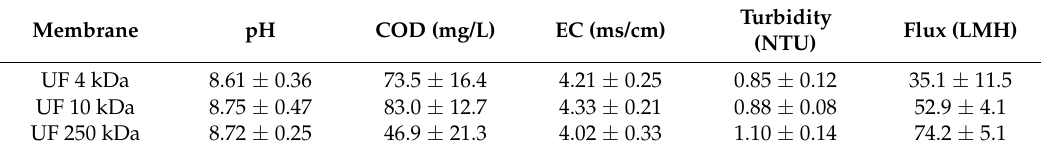
Table 4. Effluent water qualities of UF membranes.